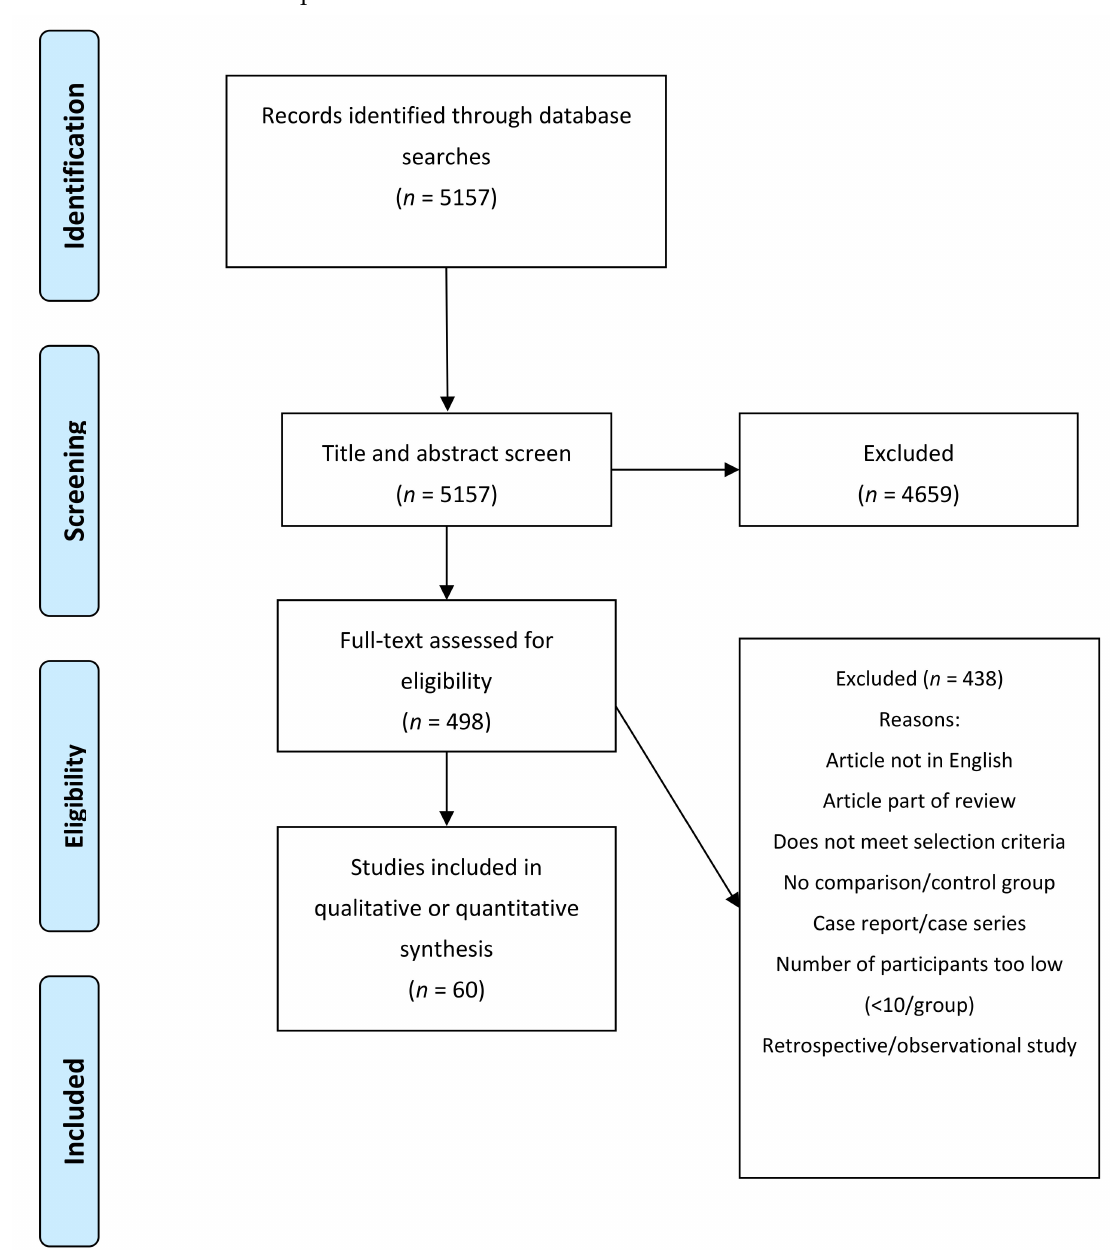
Figure 2. PRISMA flowchart of our search, screening, and inclusion strategy. Alongside the parents, decide on an individualized method of administering food to their infant. Consider various feeding methods, including breast and bottles, as well as